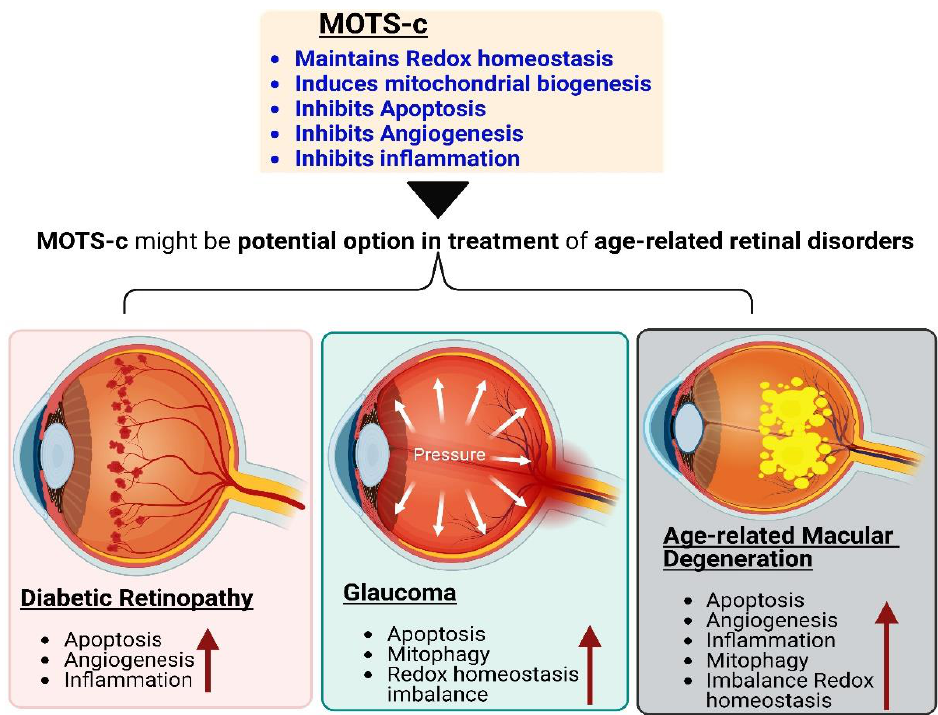
Figure 4. MOTS-potential c’s benefits make it an ideal candidate for treating diabetic retinopathy, glaucoma, and age-related macular degeneration.